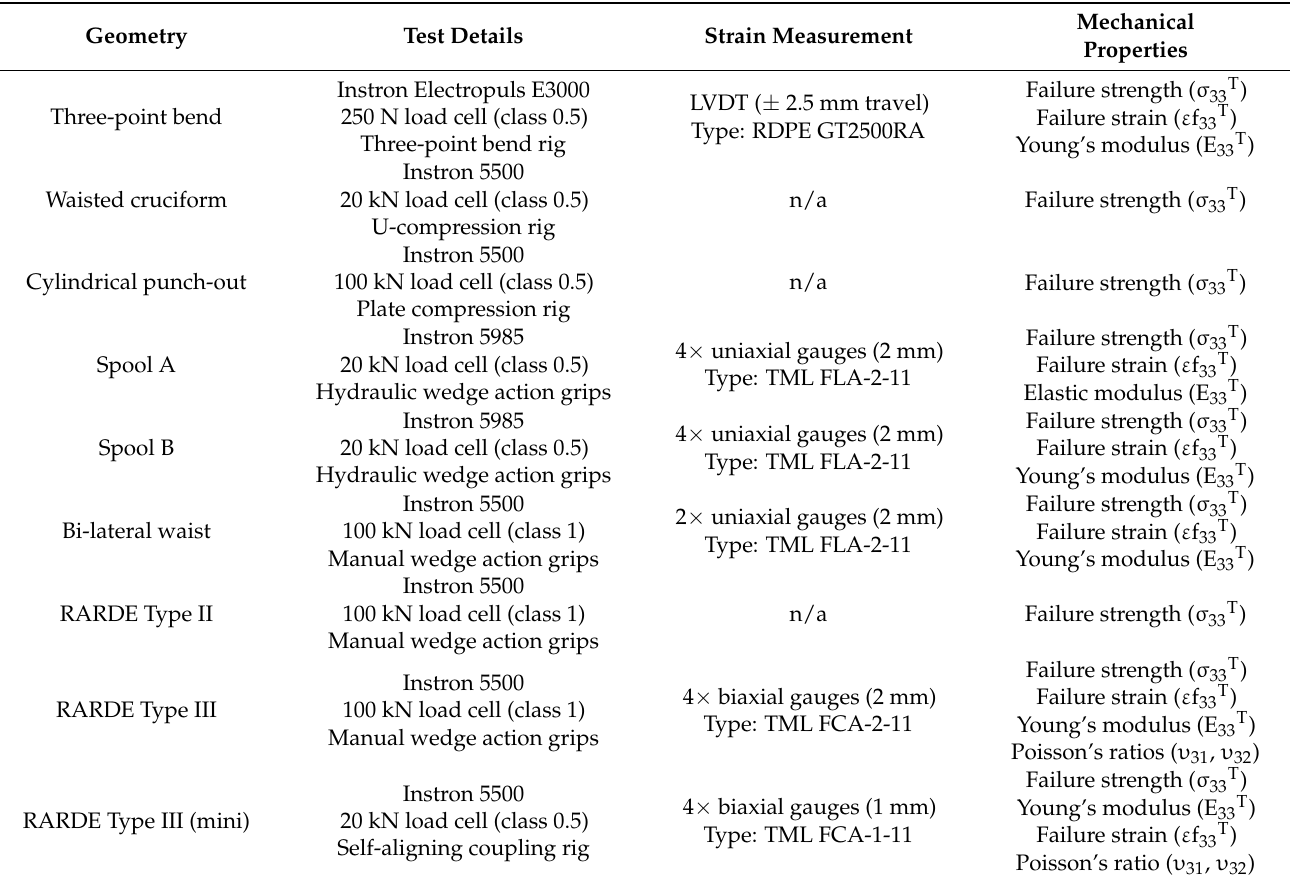
Table 3. Test details for different geometries